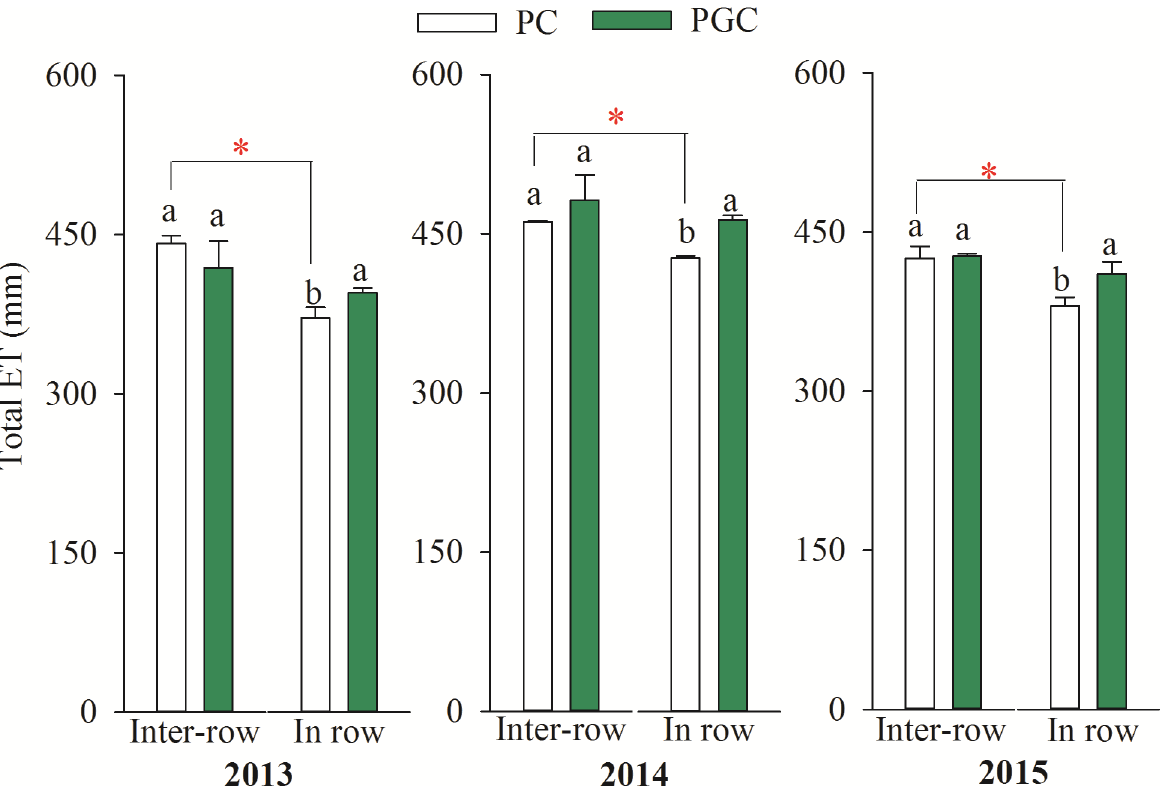
Fig 7. The total evapotranspiration during the growing period (late March to September) of apple trees in 2013, 2014 and 2015. Lowercaseletters denote significantdifferences betweenPC and PGC for the inter-row or in-row ( p (cid:20) 0.05). “ * ” indicatesthat the differencesbetweenthe inter-row and in-row (connected by lines) of the PC or PGC treatment were significant( p (cid:20) 0.05). Error bars were the standarddeviations.